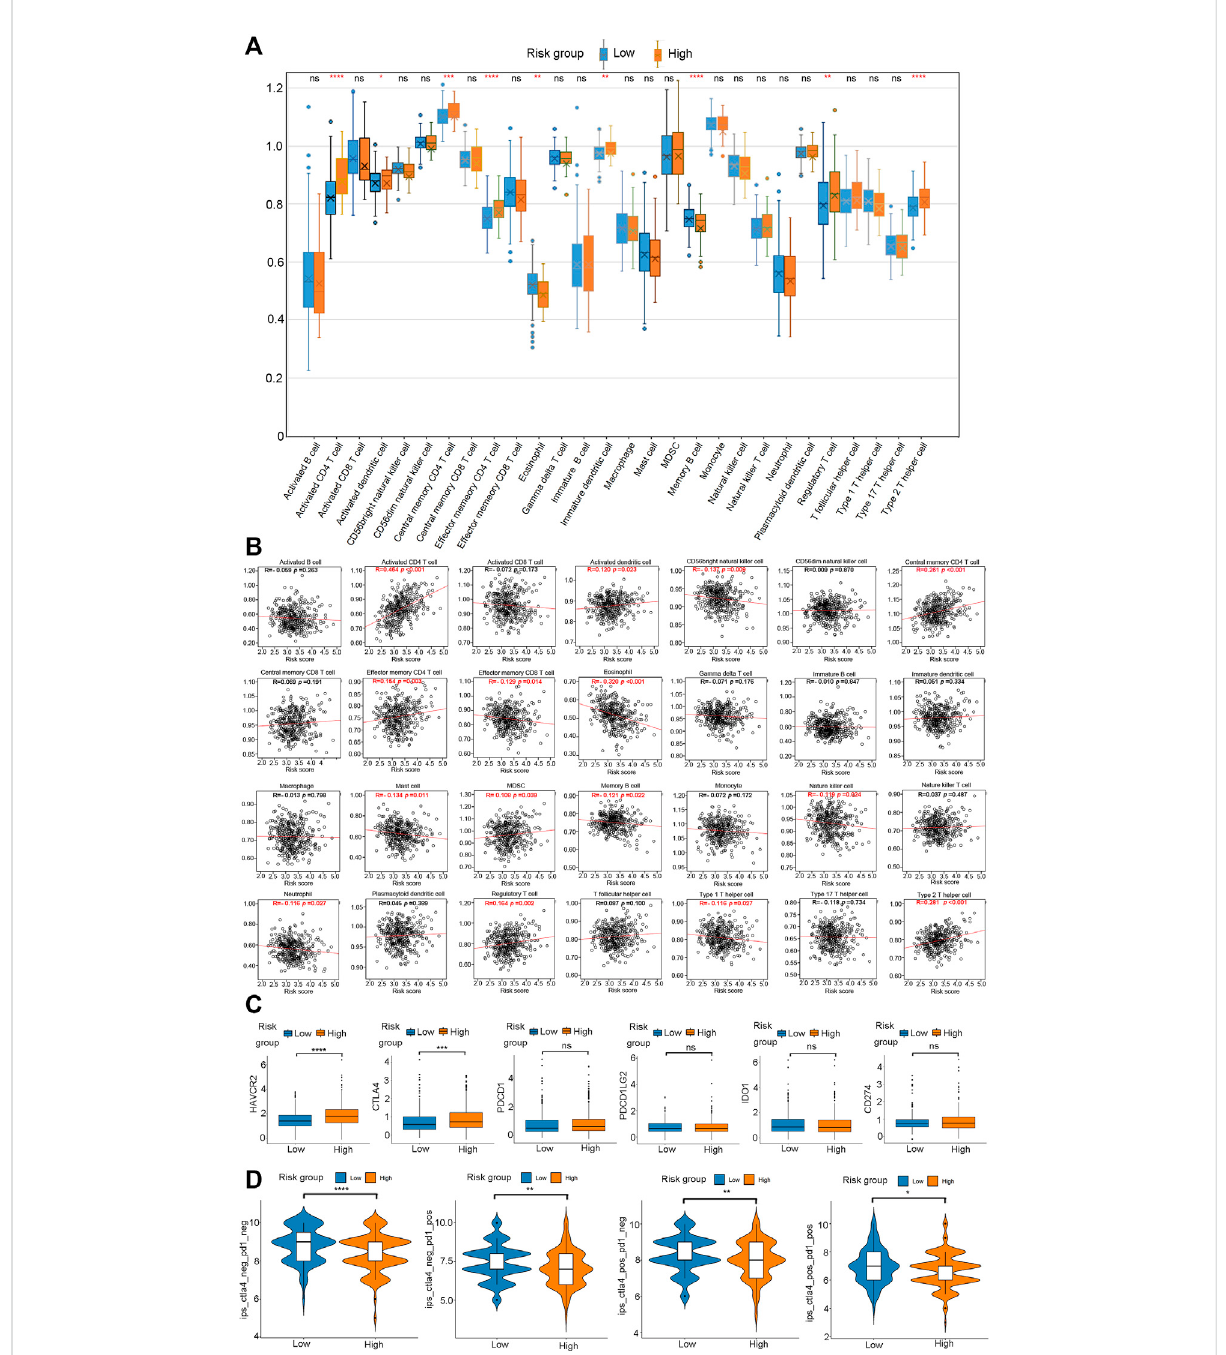
FIGURE 10 Evaluation ofthein fi ltrating immune cells, checkpoints, and immunecheckpointblockade response between the high- and low-risk group. (A) Comparasion of each TME-in fi ltrating cell between high- and low-risk groups. (B) Correlations between risk score and immune cell types. (C) The expression of six immune checkpoints (HAVCR2, CTLA4, PDCD1, PDCD1LG2, IDO1, CD274) in the high - and low-risk groups. (D) Immunotherapy response between high- and low-risk